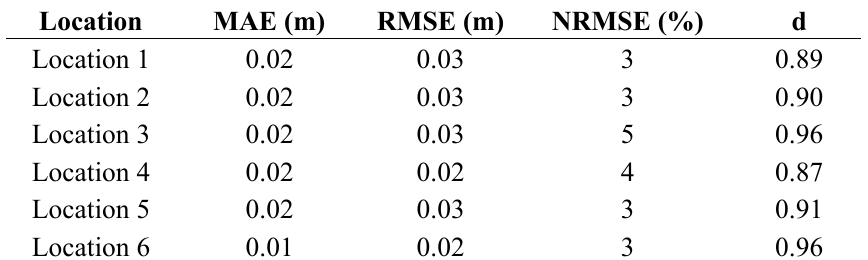
Table 3. Mean absolute error MAE, root-mean-square error RMSE, normalized root-mean-square error NRMSE and index of agreement (d) for Run 3 (14 December 2003–18 December